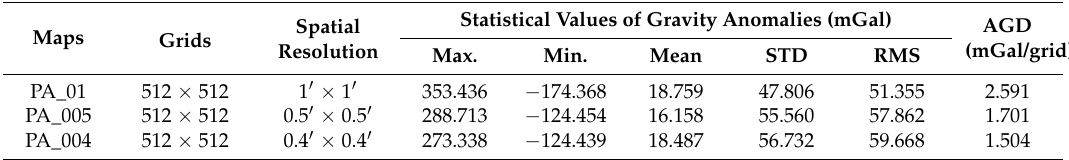
Table 2. Parameters of gravity maps PA_01, PA_005, and PA_004.